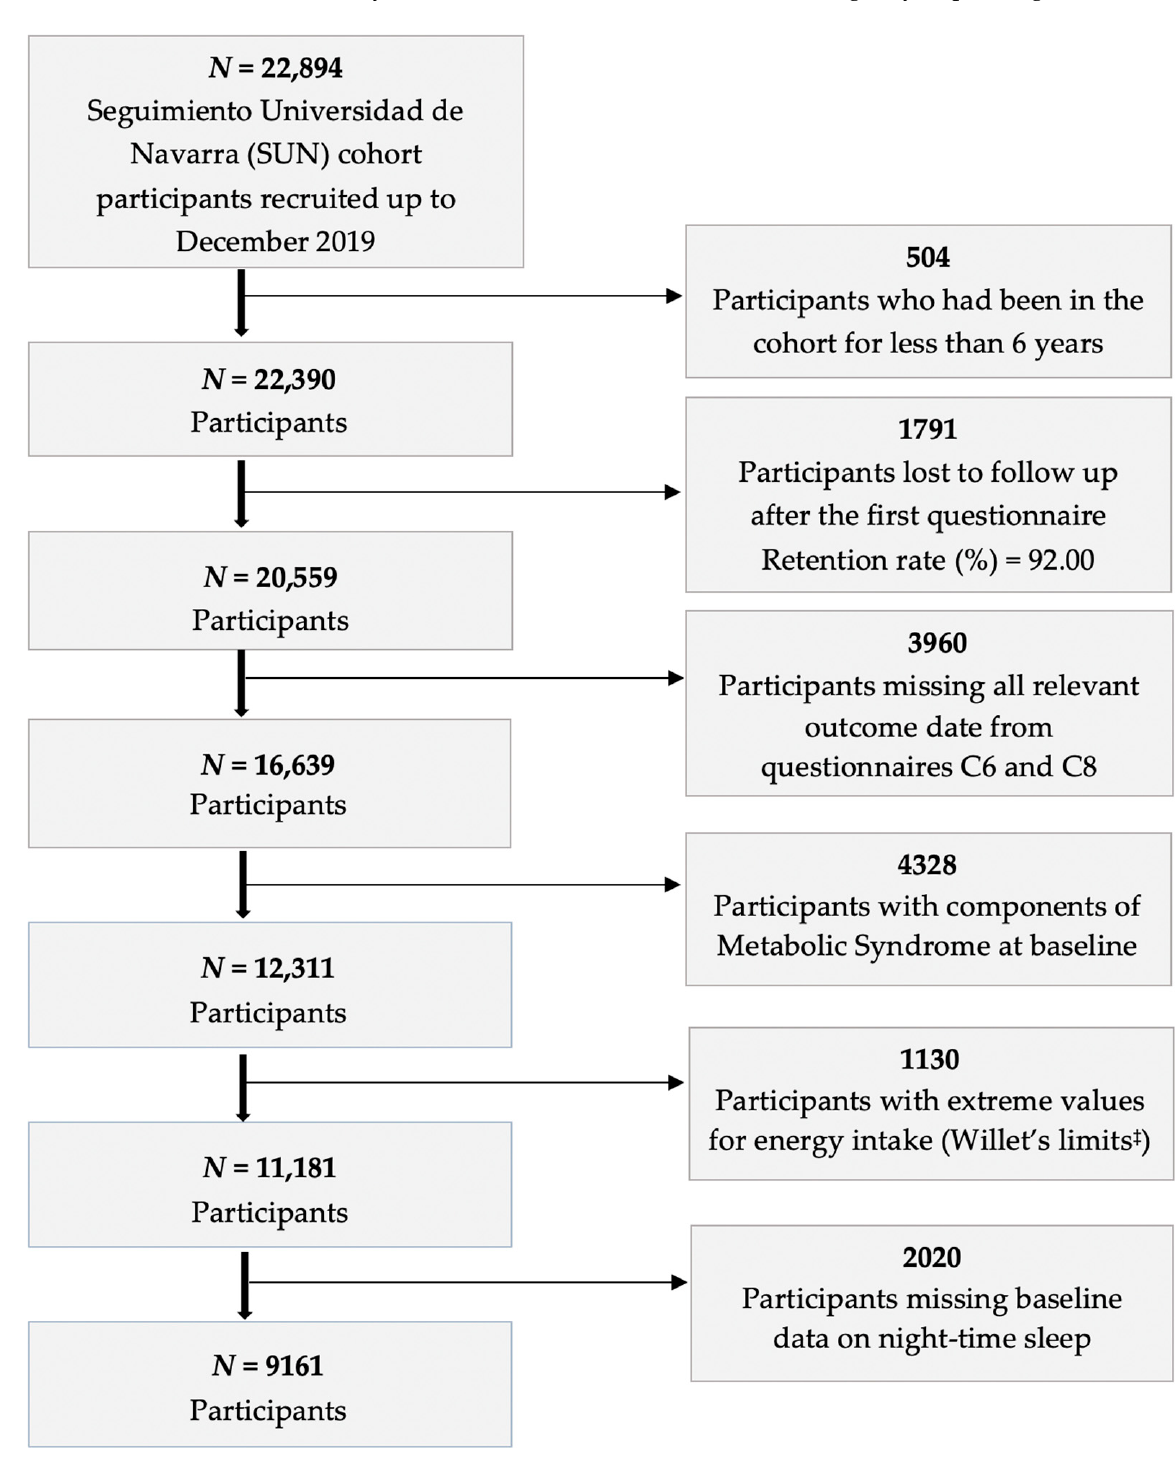
Figure 1. Flowchart depicting the selection process among participants of the SUN project (Seguimiento Universidad de Navarra, University of Navarra Follow-up) included in the present analyses. Navarra, Spain, 1999–2019. ‡ Willet 2012. Our selection criteria allowed that a participant was deemed not to meet obesity criteria for metabolic syndrome if intercurrent pregnancy affected the calculation of body mass index